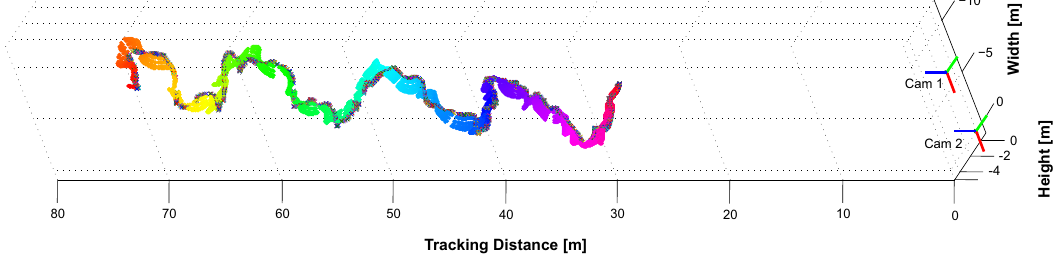
Figure 29. 3D position tracking of a moving target through the entire